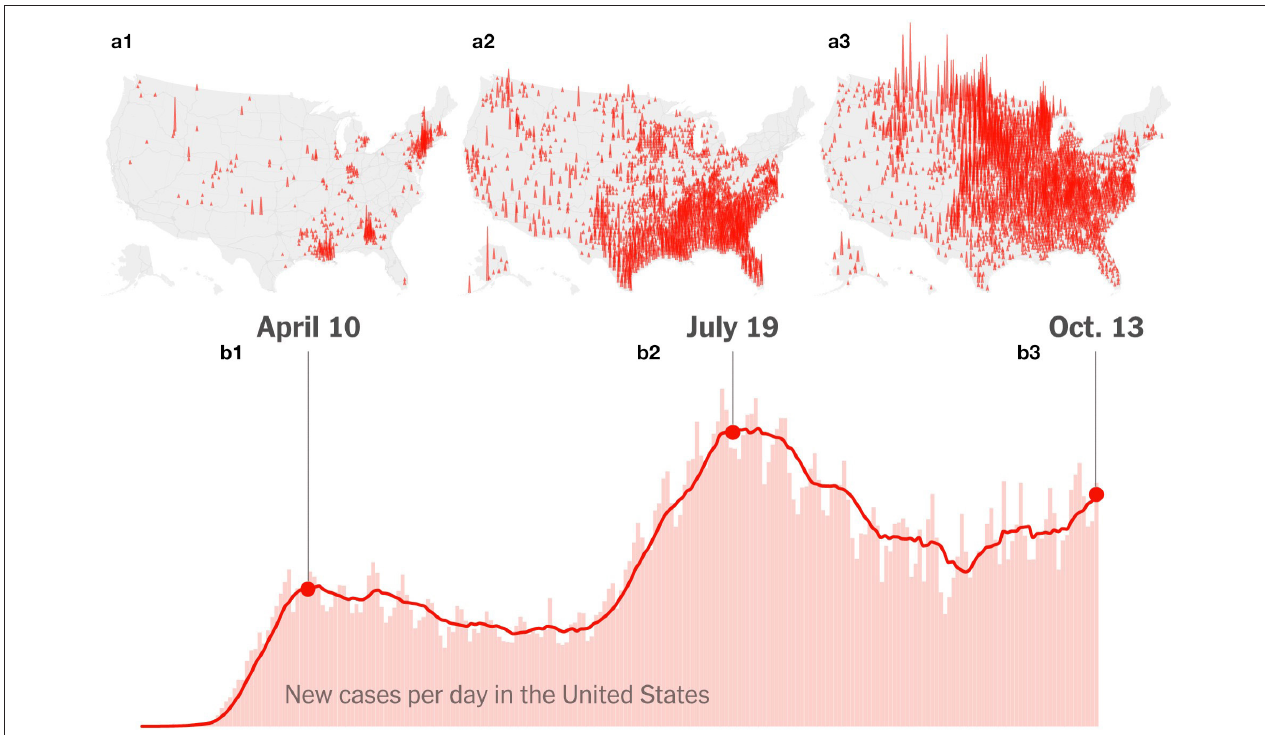
FIGURE 3 | (a) (1)–(3): Spatial Diffusion of Covid-19 cases in the United States, March-October 2020. (b) (1)–(3): Temporal Diffusion of Covid-19 the United States, March-October 2020 (Source: Leatherby, [ 51] New York Times, full figure available at: https://www.nytimes.com/interactive/2020/10/15/us/coronavirus-cases-us-